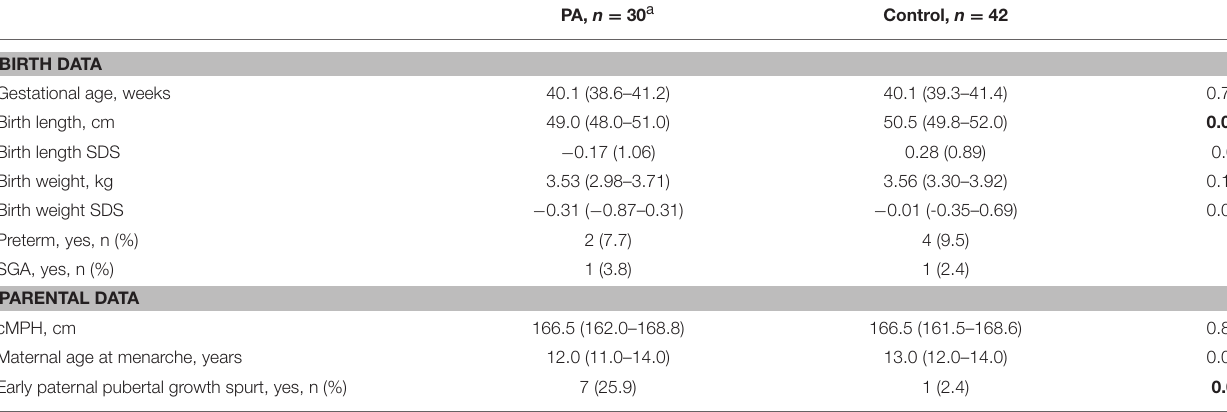
TABLE 1 | Birth and parental data of the PA and control